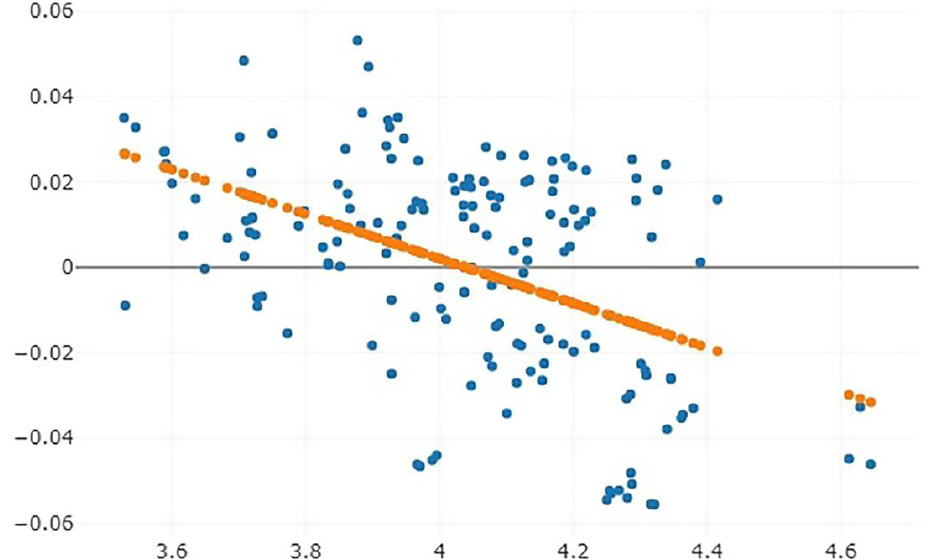
Figure 4. Allometric relationship between the wing centroid size (CS) and wing shape of Lutzia mosquito specimens. The linear regression prediction is shown by the orange dotted line; the y-axis shows the wing shape, and the x-axis shows the wing CS.